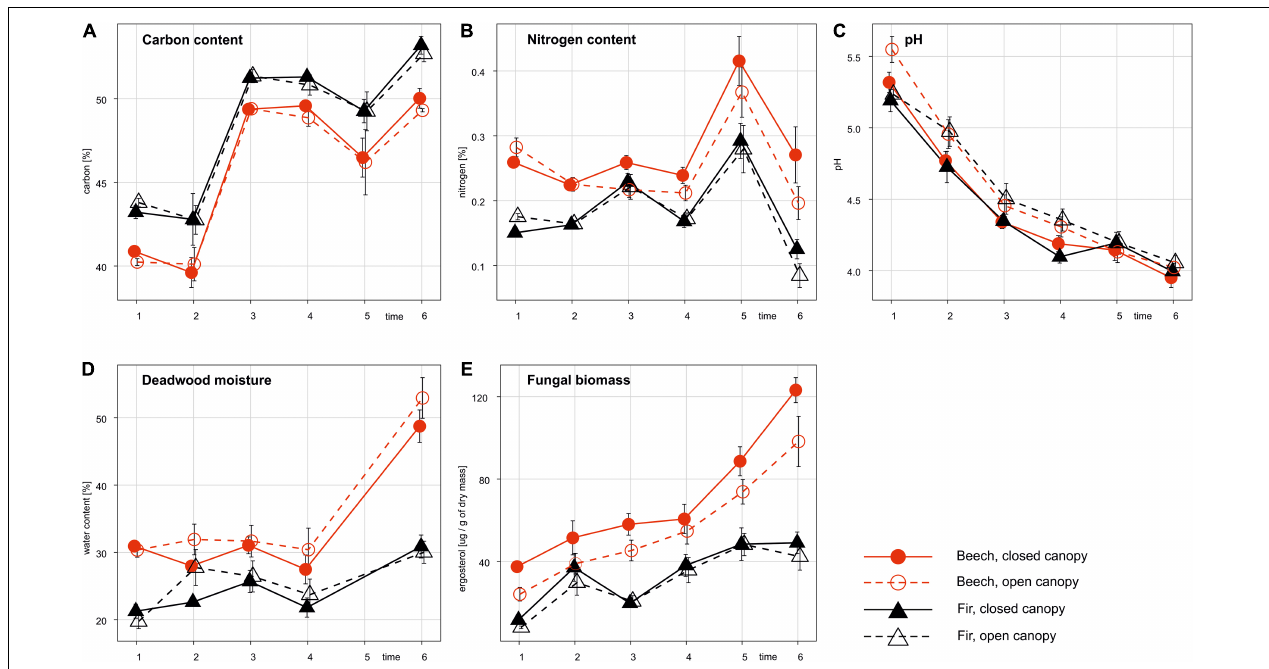
FIGURE 1 | Fungal biomass (E) and changes in physicochemical compositions (A–D) of fine beech and fir deadwoods during decomposition in a natural temperate forest. Data represent the mean ± SE of 16 samples per treatment and timepoint (years).